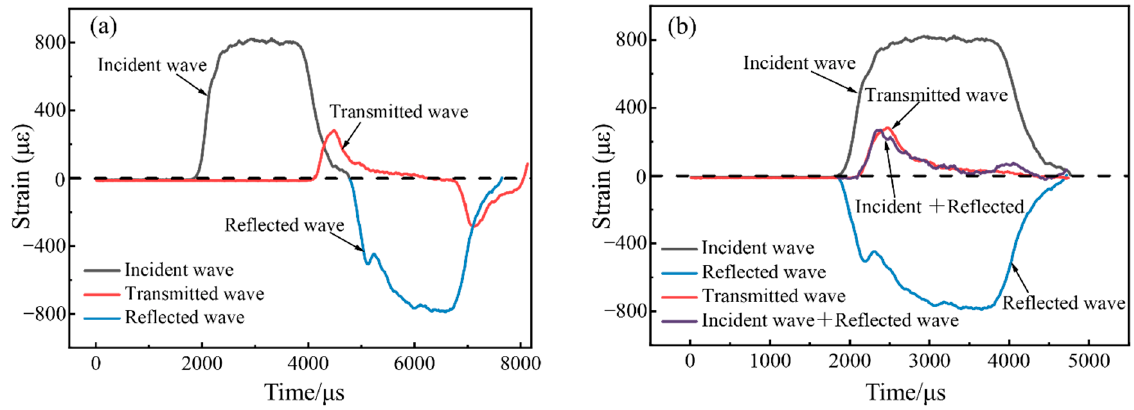
Figure 5. Typical stress wave: ( a ) before waveform alignment and ( b ) after waveform alignment.